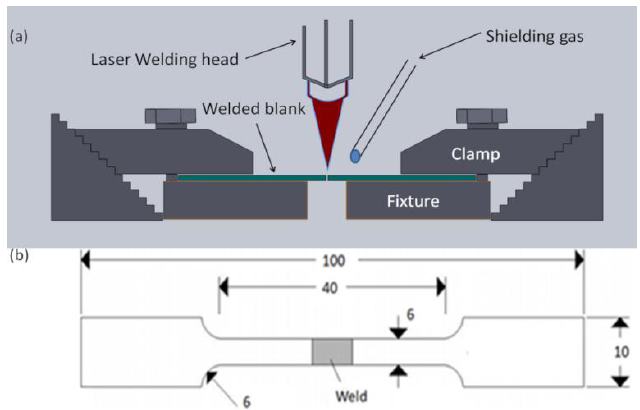
Figure 1. Illustrative schematics of ( a ) welding setup, and ( b ) ASTM E8 tensile sample geometry for Quasi-Static Tests (Dimensions are in mm).